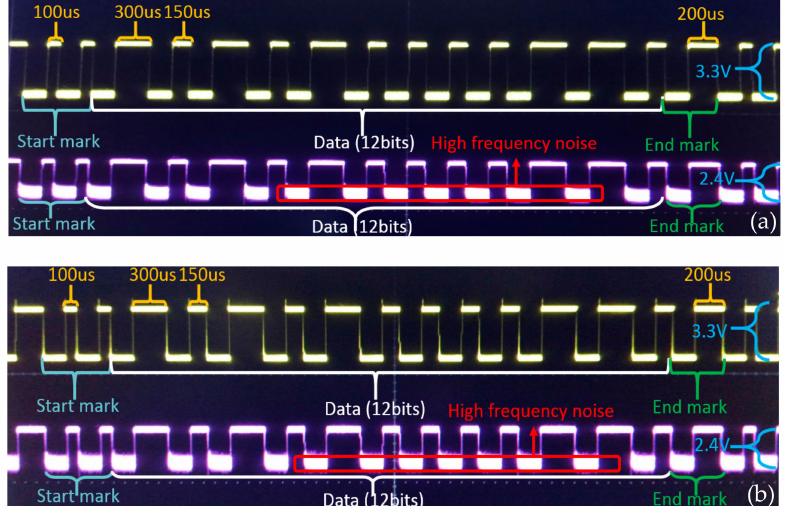
Figure 9. The waveform of transmission between ( a ) control terminal and follower robot ( b ) follower robot and leader